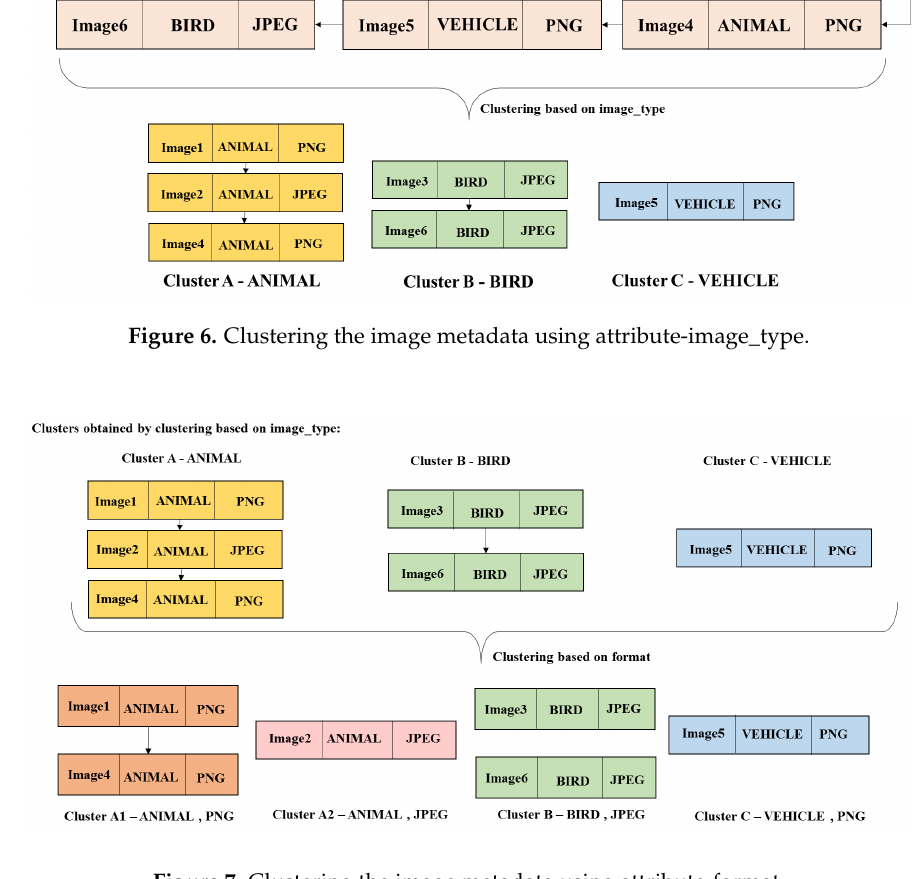
Figure 7. Clustering the image metadata using